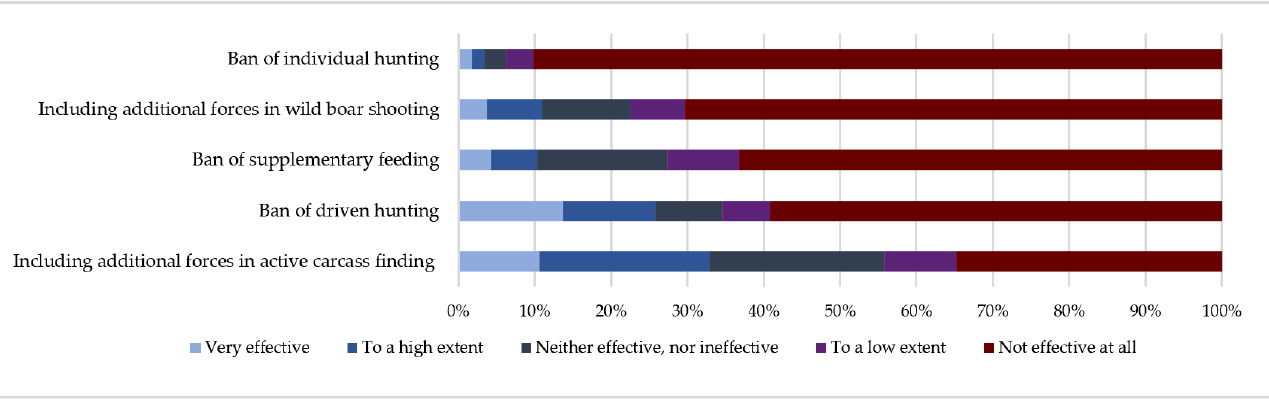
Figure 2. The least effective measures to eliminate ASF in wild boar population perceived by Lithuanian hunters responding to the anonymous survey.